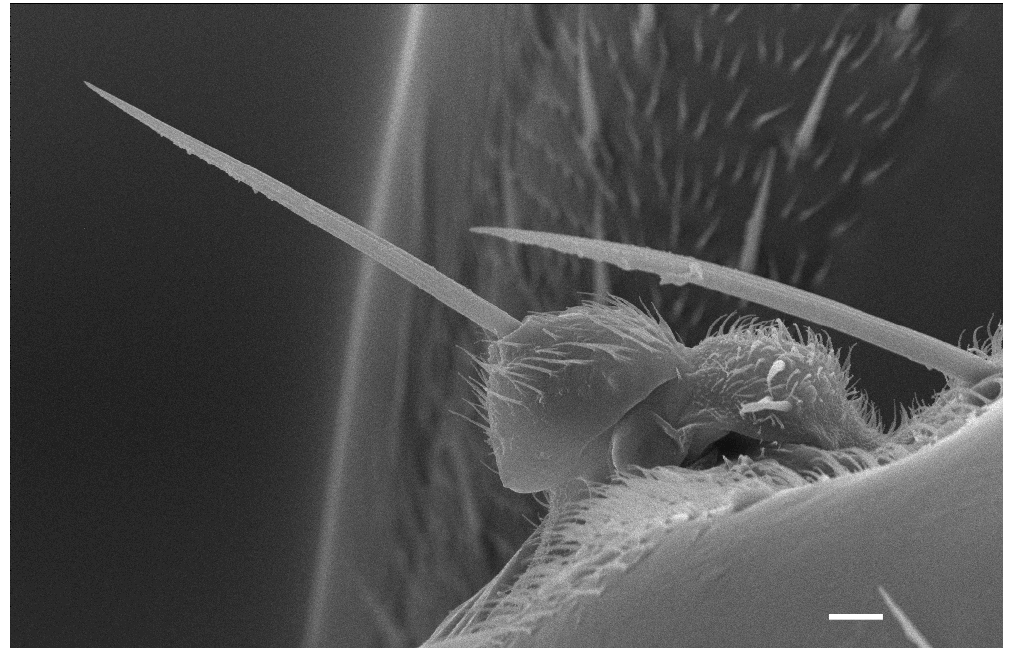
Fig. 22. Image obtained by scanning electron microscope (SEM) of the micropterous wing of a male of Tachydromia apterygon Plant & Deeming, 2006. Scale bar: 10